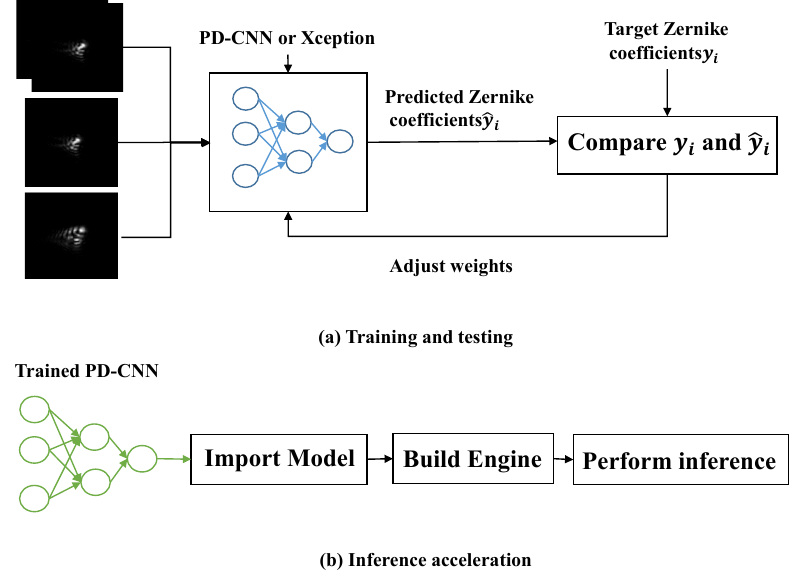
Figure 4. The experiments in this paper. ( a ) the part of training and testing neural network. ( b ) the part of inference